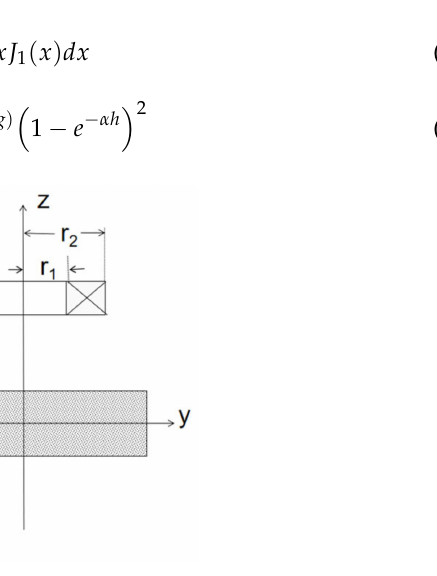
Figure 2. Full-view and cut-view of the planar metal